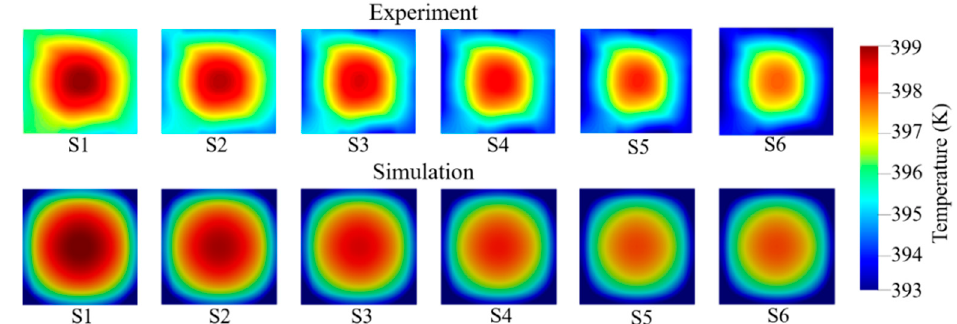
Figure 9. Temperature contour comparison between experiment and simulation in streamwise direction of straight pipe.